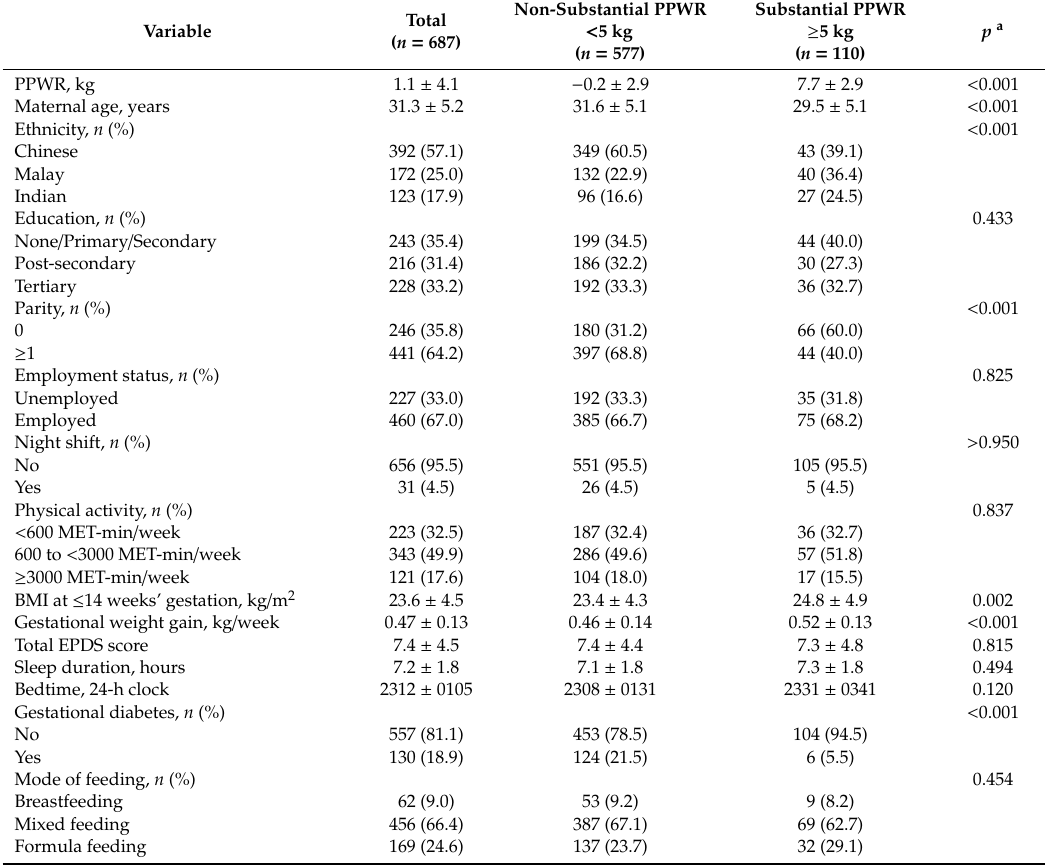
Table 1. Descriptive characteristics of women from the GUSTO study.